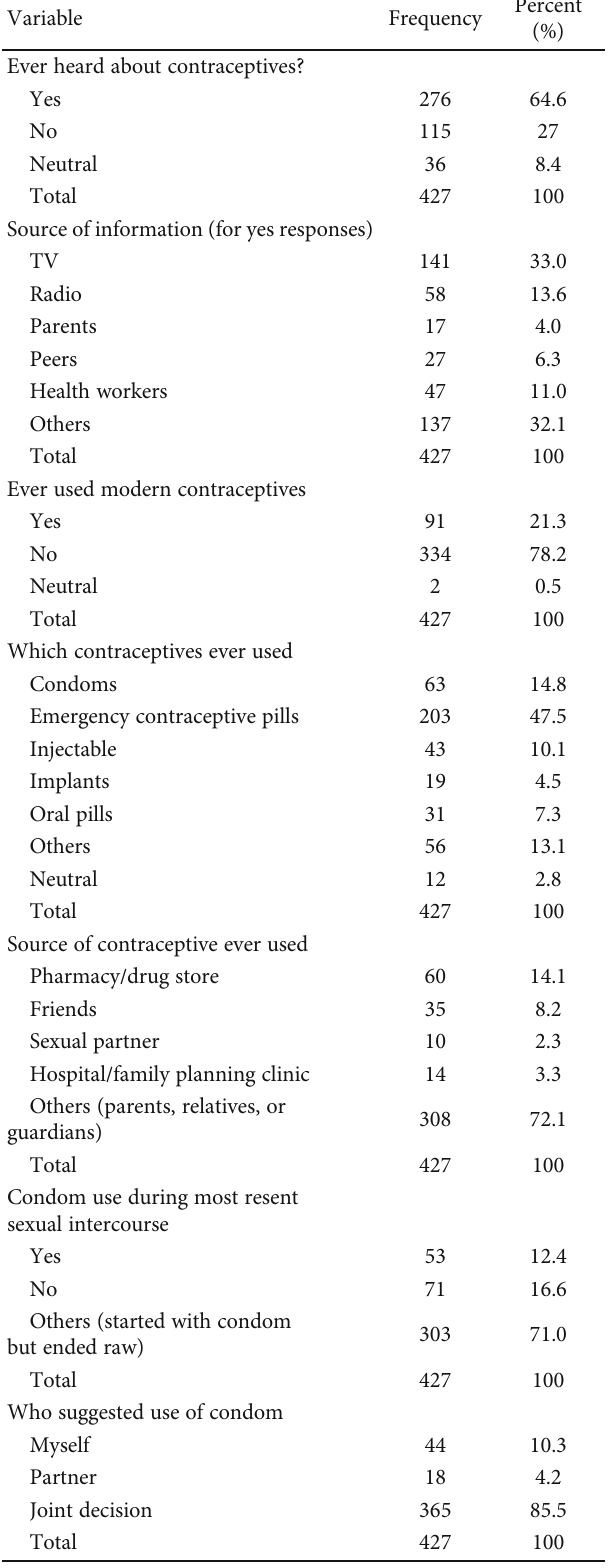
Table 3: Respondents ’ awareness and use of contraceptives.